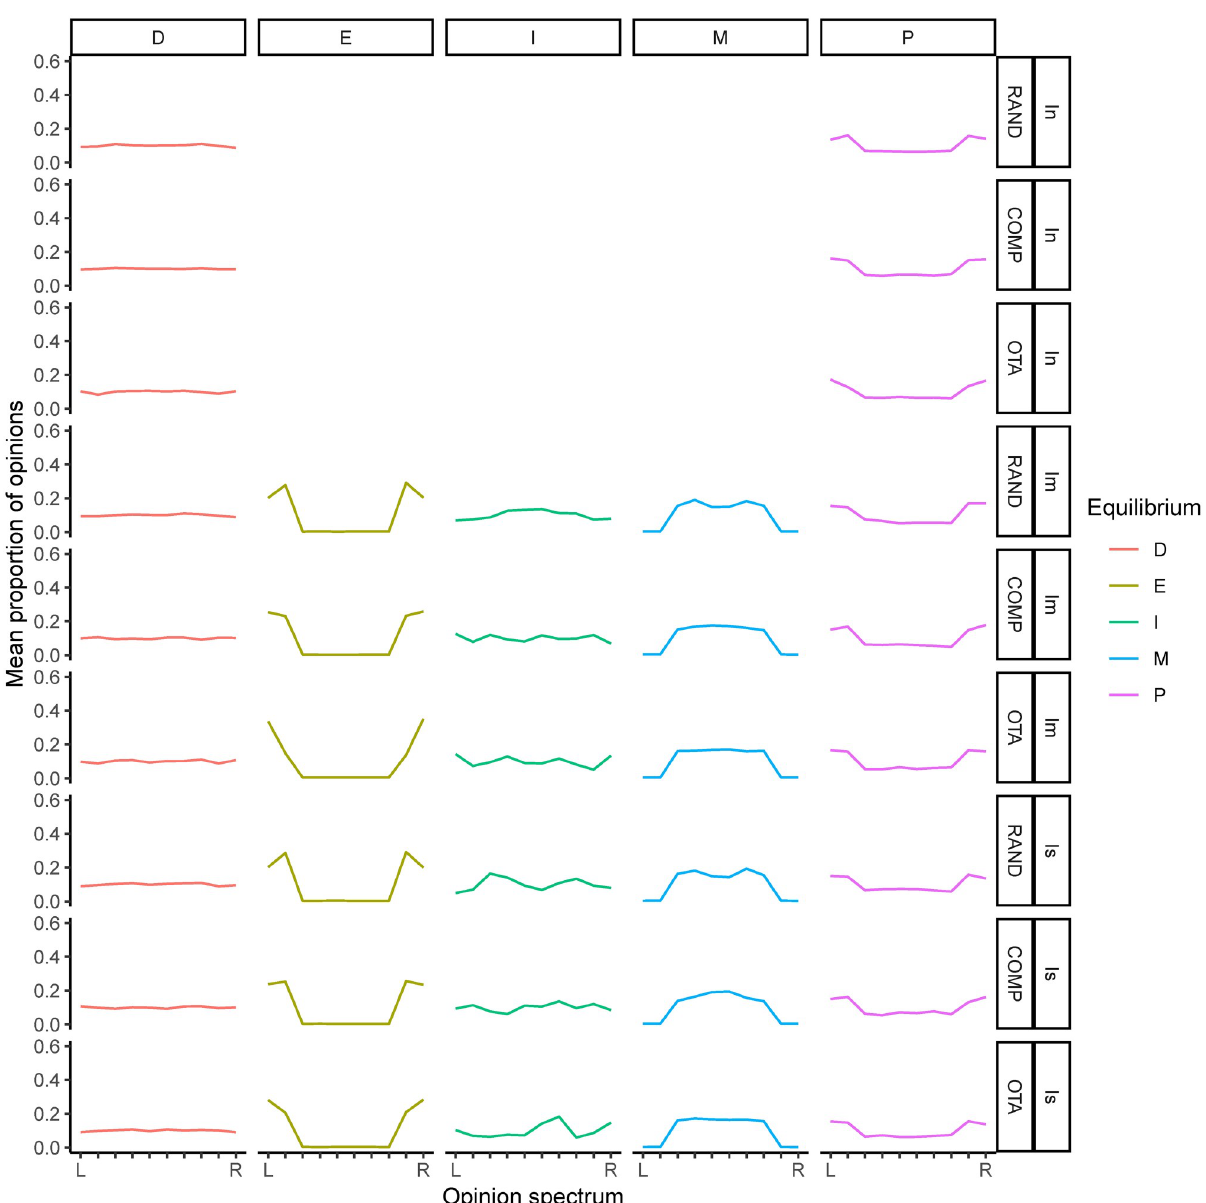
Fig 10. Mean proportion of opinions under opinion-aggregating institutions in each type of opinion equilibrium by condition after 2000 simulations. We exclude low frequency events (which may reduce the reliability of the opinion distribution and lead to higher margin of error) by removing any output that occurs less than